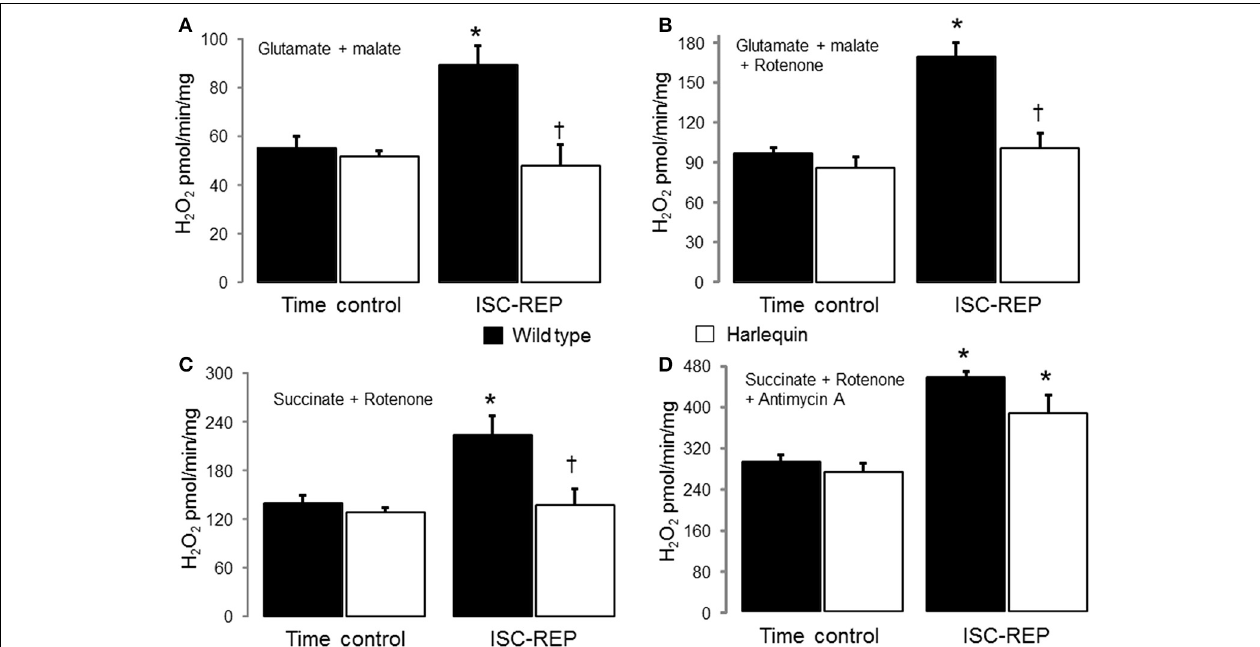
FIGURE 1 | Ischemia-reperfusion (IR) increases the net H 2 O 2 production in wild type but not in Hq mouse cardiac mitochondria. There were no differences in the net release of H 2 O 2 between wild type and Harlequin mouse heart mitochondria from non-ischemic hearts. IR increased the generation of H 2 O 2 in wild type but not in Harlequin mice compared to time control (A) . The maximal H 2 O 2 generation from complex I was measured using rotenone to inhibit complex I. An AIF deficiency in Harlequin mice did not alter the maximal H 2 O 2 generation from complex I compared to wild type in control heart (B) . The maximal